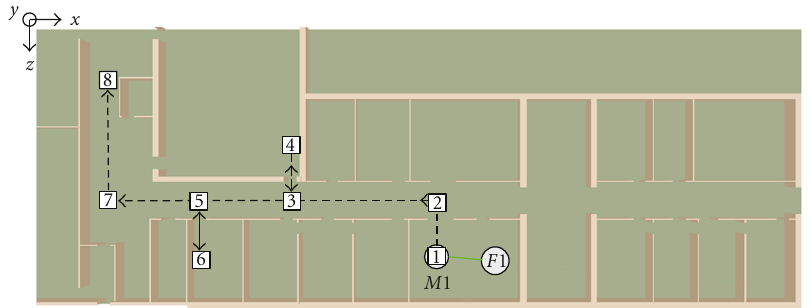
Figure 12: A dynamic